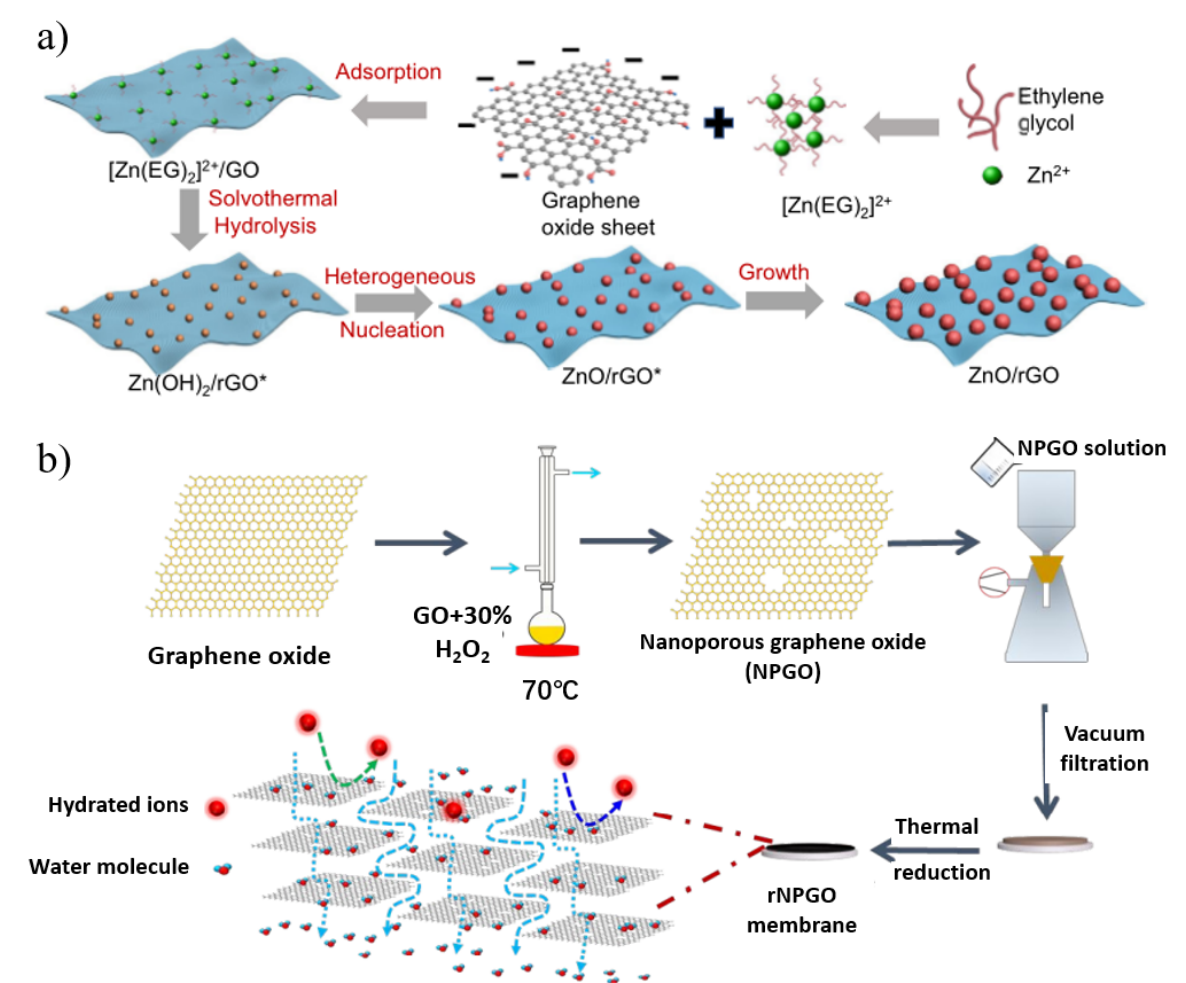
Figure 7. ( a ) Schematic illustration of the growth mechanism of ultrafine ZnO/rGO nanocomposites. ( b ) Schematic illustration of the fabrication process of reduced nanoporous graphene oxide (rNPGO) membrane. Reprinted with permission from [106,107]. Copyright (2019) American Chemical Society. Copyright (2022) published by the author(s).